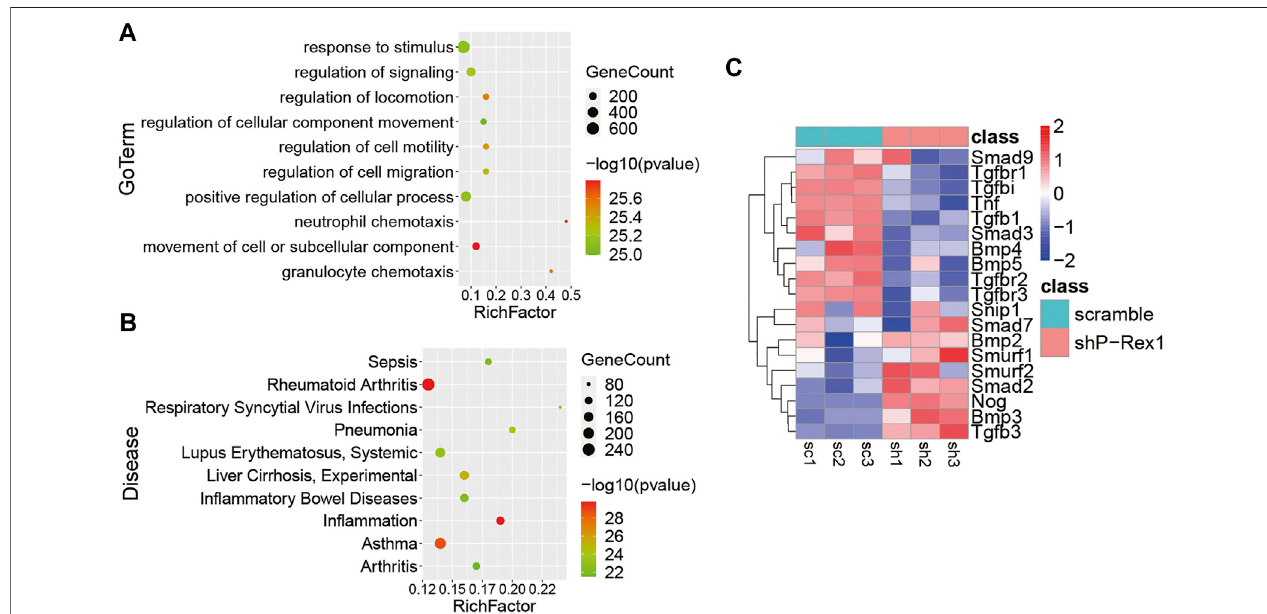
FIGURE 5 | Identi fi cation of the role for P-Rex1 in lung fi broblasts using next-generation sequencing. (A) Gene Ontology (GO) enrichment showing top changes of cellular functions in P-Rex1 downregulated fi broblasts compared to control cells. (B) Bubble chart showed the top disease enrichment associated with P-Rex1 downregulation in lung fi broblasts. (C) Heatmap diagram showed the expression of Smad-dependent TGF- β 1 signaling pathway related genes in P-Rex1 knockdown and scrambled control fi ( Figure 5A ). Kyoto Encyclopedia of Genes and Genomes (KEGG)